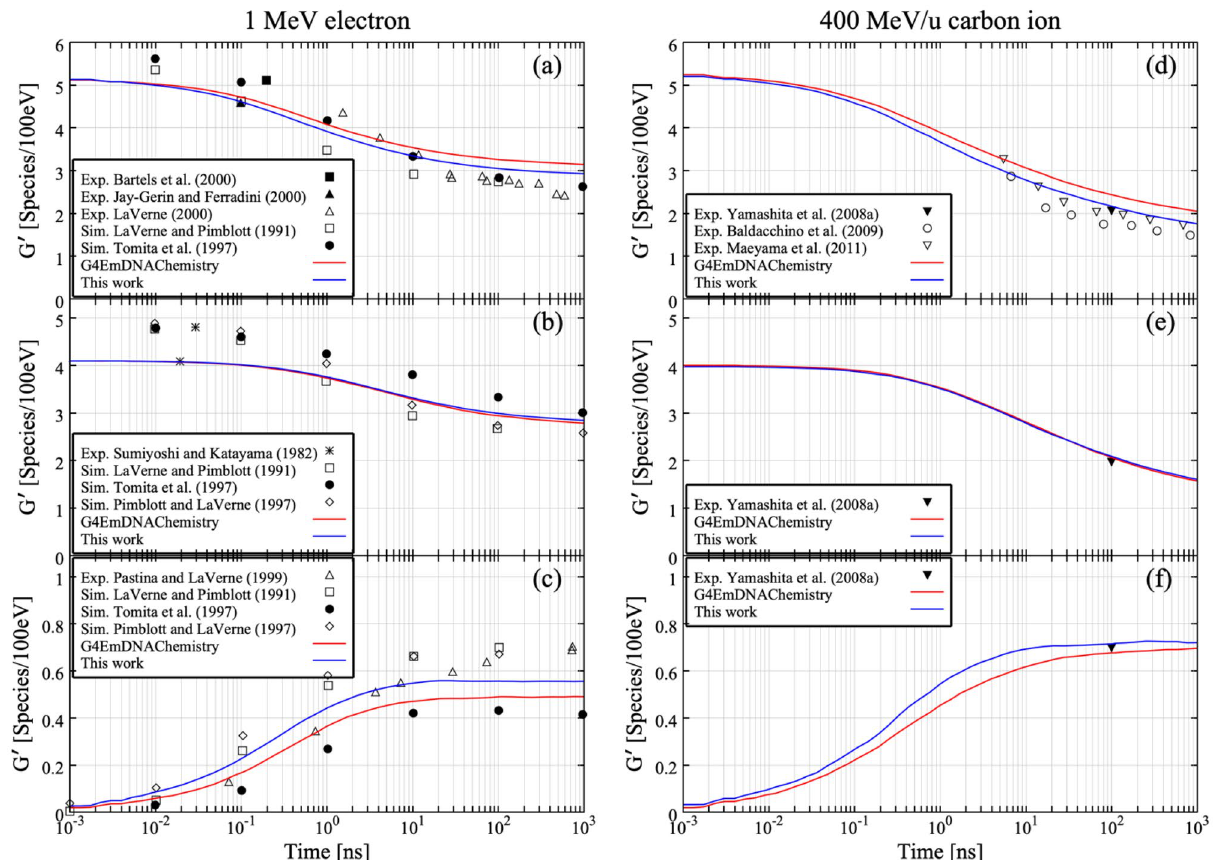
Figure 2. Time dependence of G-values of ( a ) · OH, ( b ) e aq − and ( c ) H 2 O 2 for 1 MeV electrons, and ( d ) · OH, ( e ) e aq − and ( f ) H 2 O 2 for 400 MeV/u carbon ions. The solid lines represent the results of Monte Carlo simulations. Sets of reference data 36–43 were used for comparison with simulated time dependence of G-values.